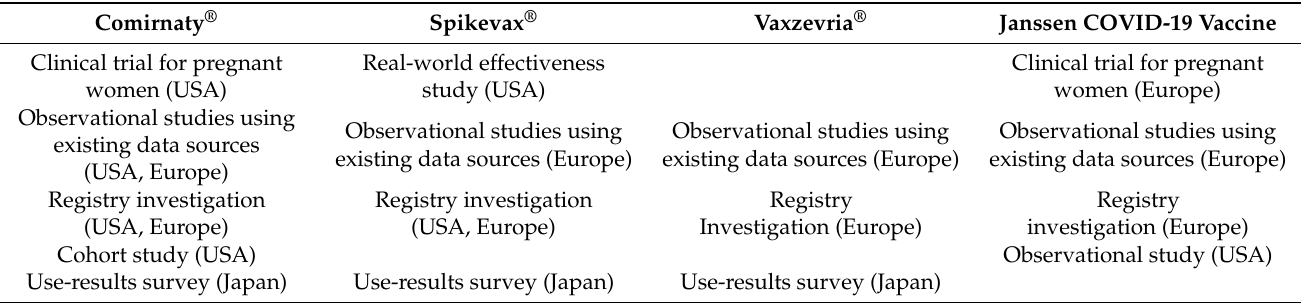
Table 2. Post-approval surveillance of pregnant women receiving the SARS-CoV-2 vaccine. Comirnaty